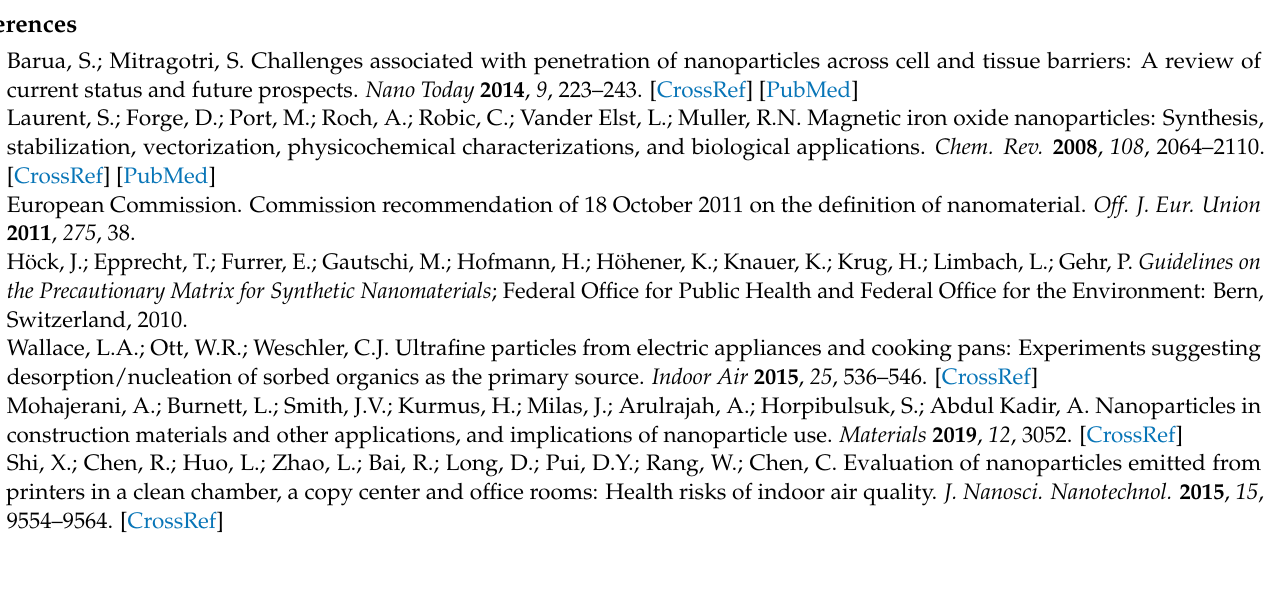
Figure A24. The average nanoparticle concentration in each size fraction in Building 12 during a one-week measurement period during the nonheating season.